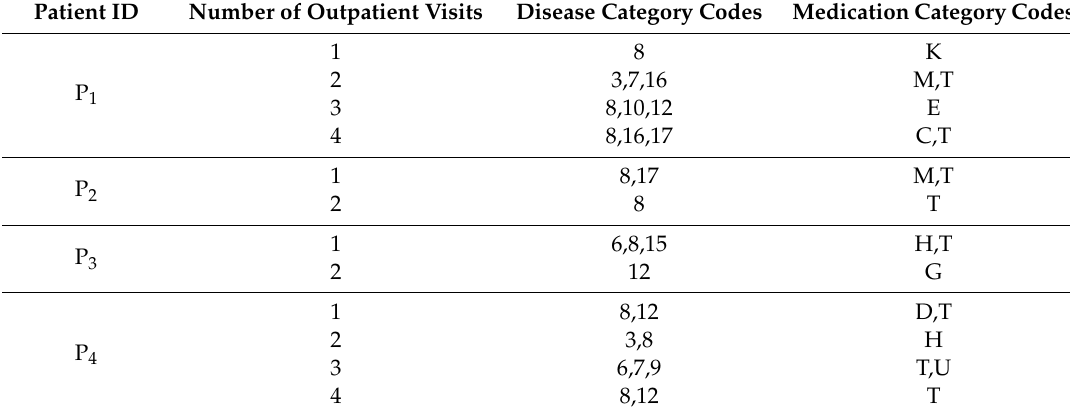
Table 4. Examples of patients’ outpatient